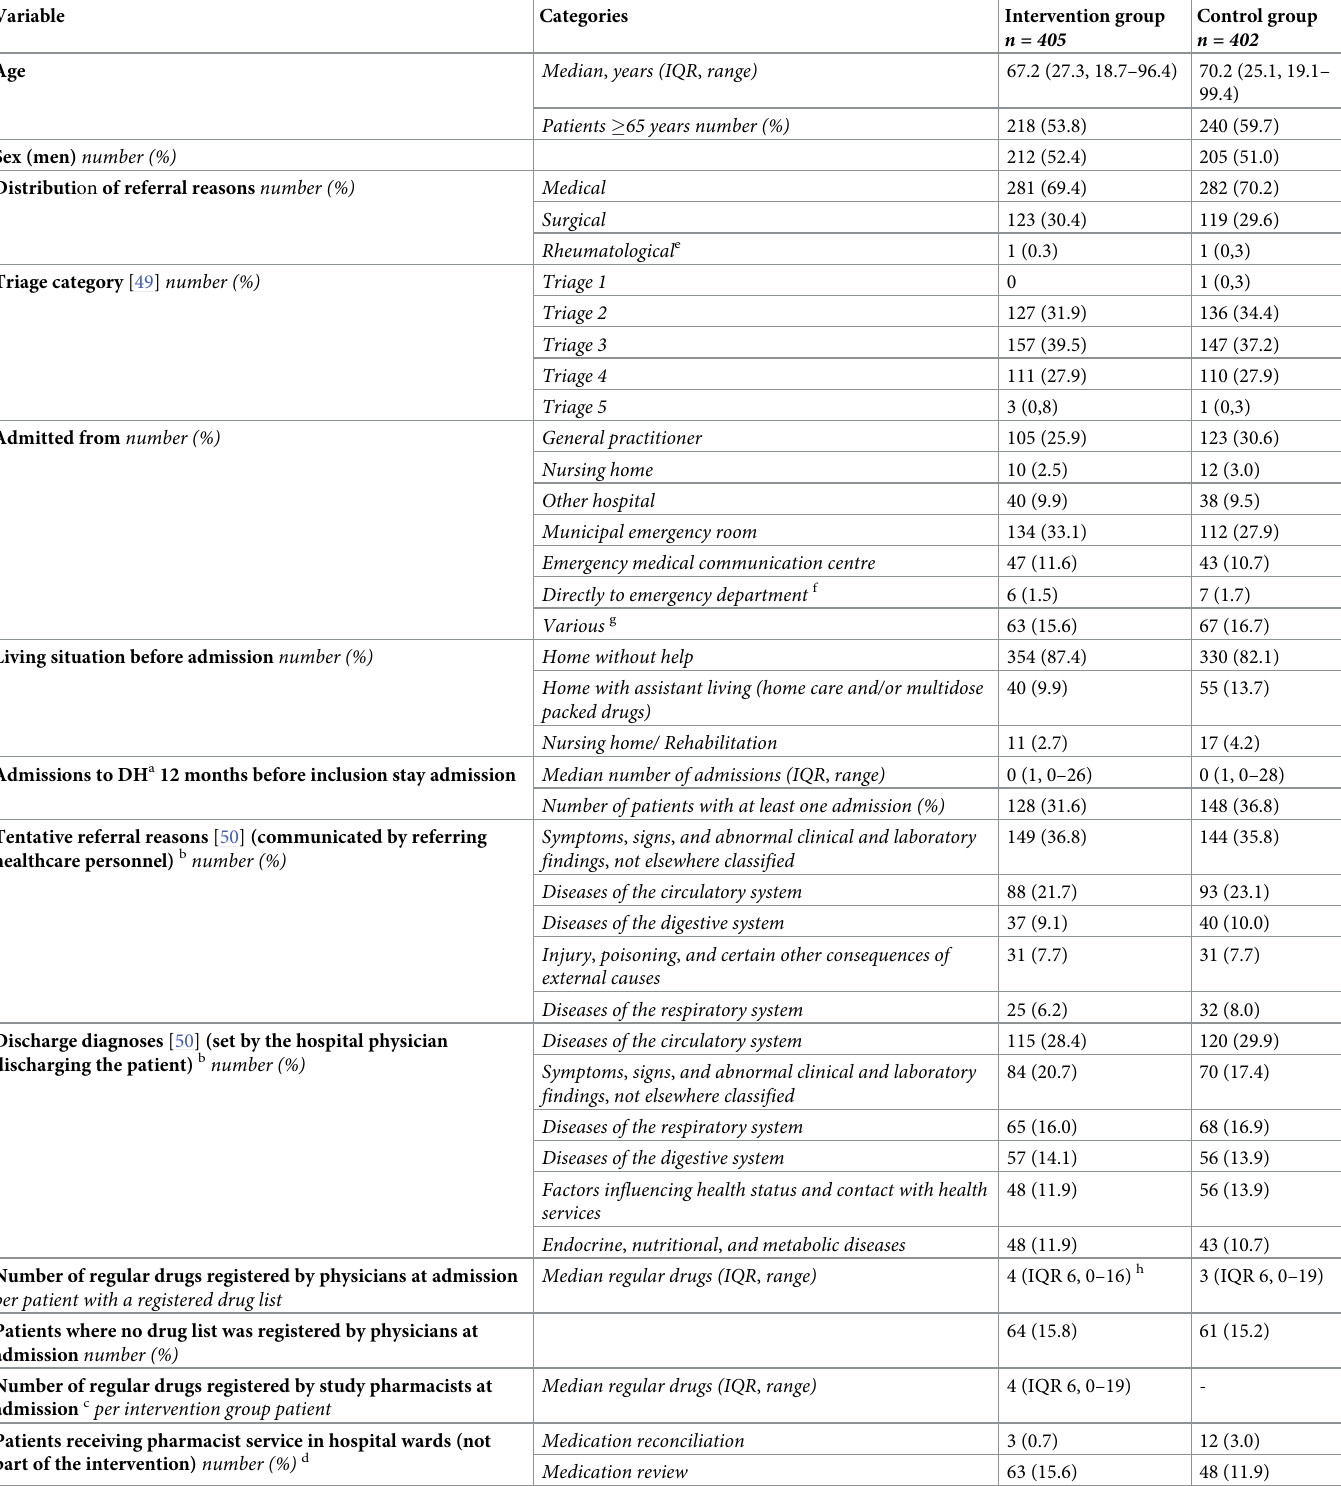
Table 1. Demographics of included